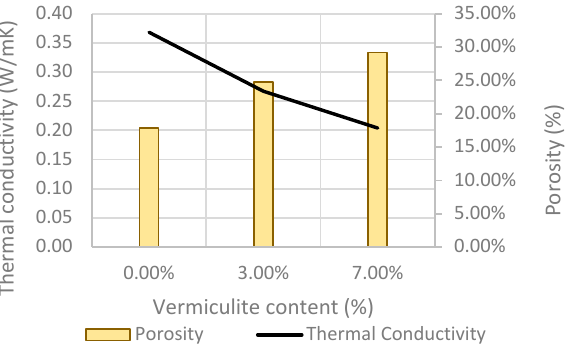
Figure 12. Correlation of vermiculite content, thermal conductivity, and porosity results from the study by Palomar et al. (2015) [44].